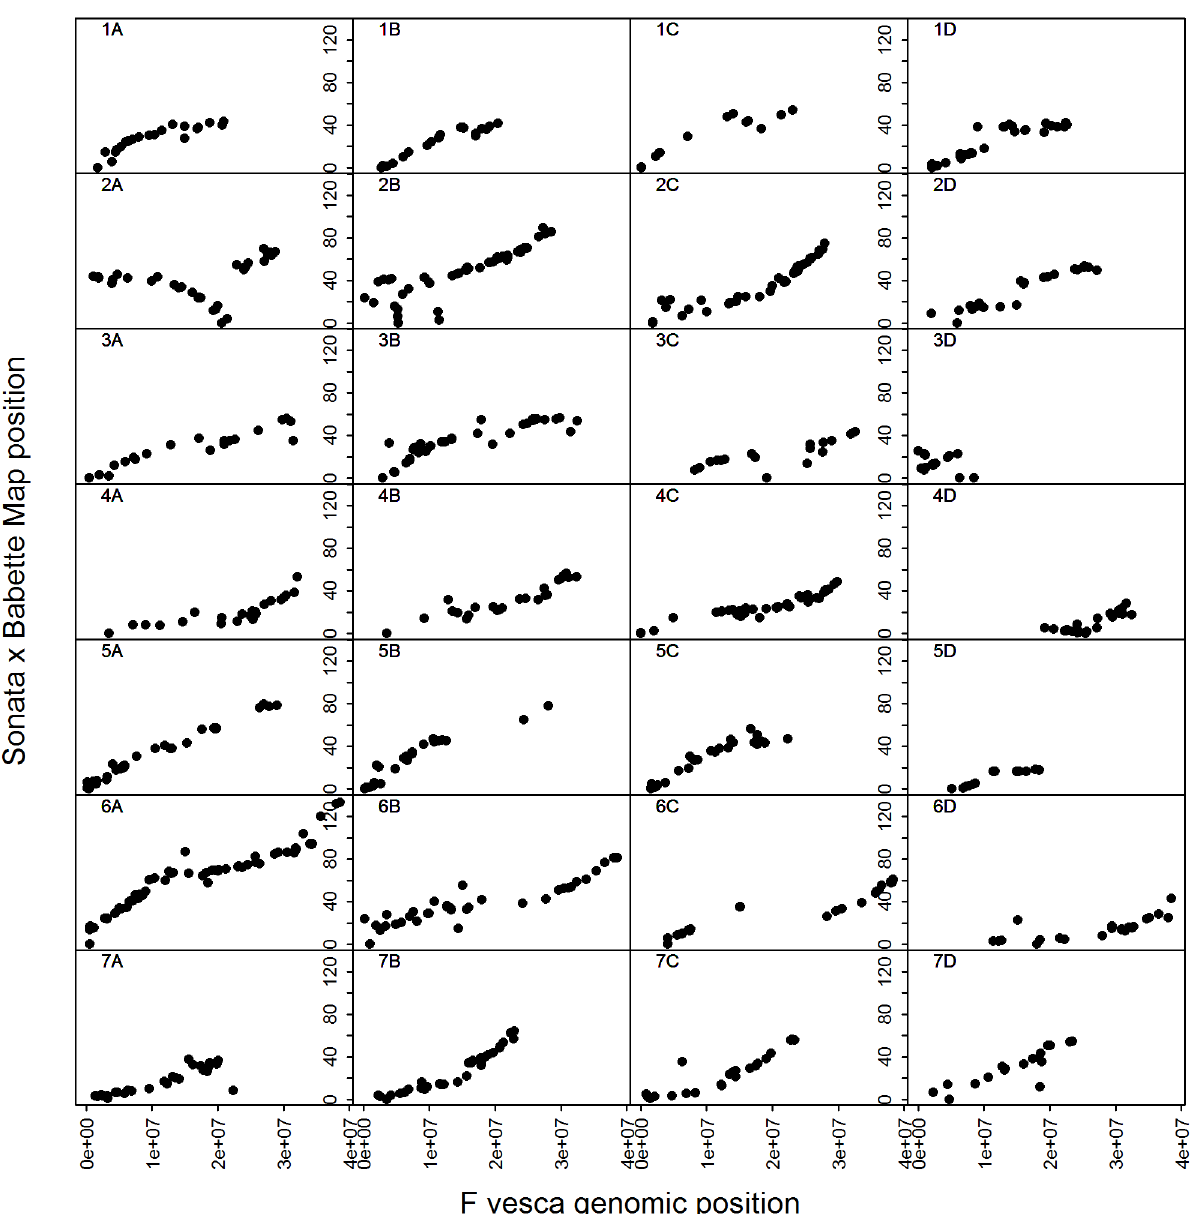
Fig 2. Marey Map plots of SNPs mapped to positions on the 28 F . ×ananassa chromosomes vs. their physical positions on the v2.0 F . vesca ( Fvb ) pseudomolecules. Linkage sub-group fragments for groups LG5D, LG6C and LG7B have been joined with an artificial gap of 10 cM between fragments to facilitate data